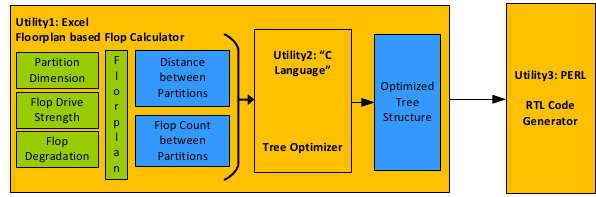
Figure 2 . Overview of RTL Generator Framework